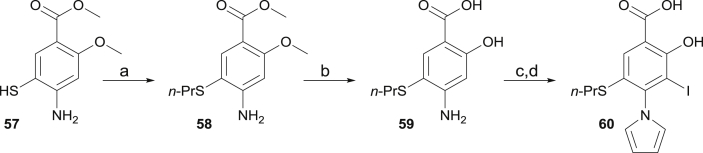
Synthesis of thioether-functionalized derivative 60.aaConditions: (a) n-PrI, Cs2CO3, DMF, 0 °C to rt, 41%; (b) BBr3, CH2Cl2, 0 °C, 77%; (c) NIS, MeCN, 0 °C; (d) 2,5-dimethoxytetrahydrofuran, AcOH, 80 °C, 30% over 2 steps.